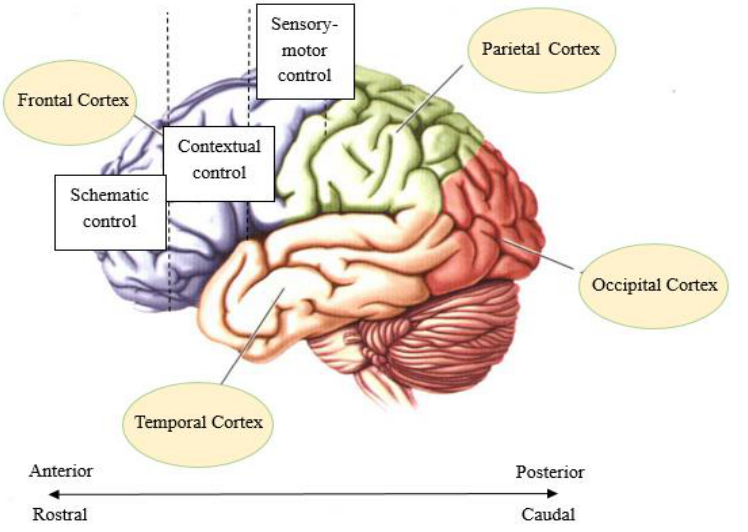
Figure 1. A hierarchical representation of cognitive control from the caudal to the rostral on the prefrontal cortex.